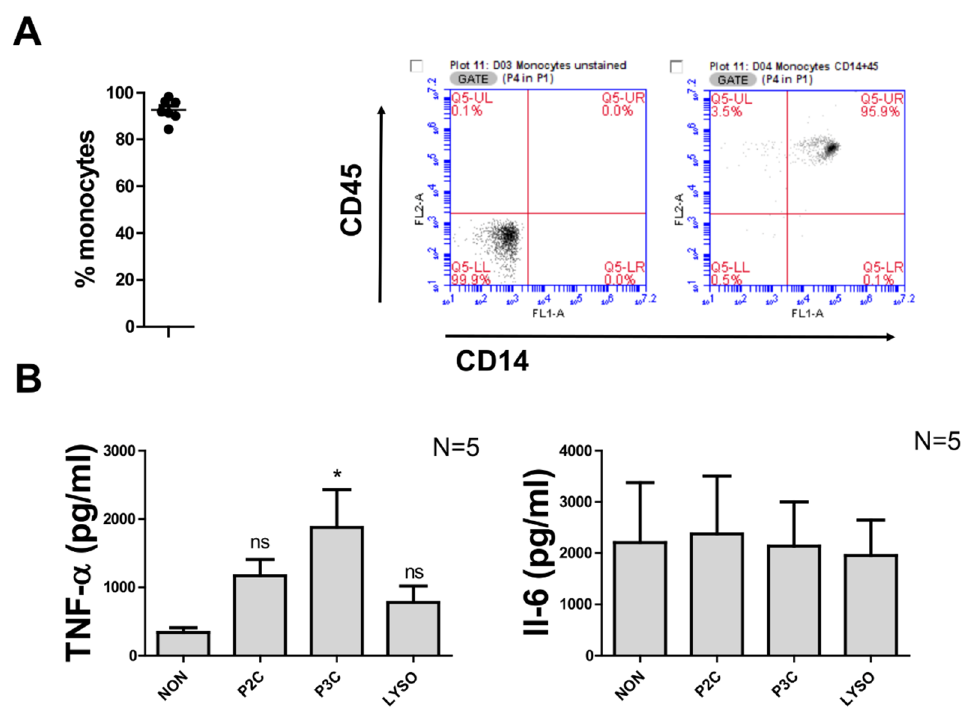
Figure 2. Monocyte production of CD14 + monocytes; positive isolation without resting. ( A ). Percentage of CD14 + monocytes from purified monocytes by CD14 + magnetic bead. Cells were stained with CD14-FITC and CD45-PE antibodies. Data were obtained from 7 donors. Flow cytometric analysis from a representative experiment with CD14 + monocytes unstained (left) and stained (right) with CD14-FITC and CD45-PE antibodies. ( B ) The 10 5 monocytes were stimulated with 100 ng/mL of P2C, P3C, or Lyso. The control samples (non) were used without adding any stimulators. TNF values were measured by ELISA from supernatant of 5 h stimulation, and IL6 and IL-10 were measured by ELISA from supernatant of 18 h stimulation. Samples from 4 donors were analysed in triplicate. Error bars represent SEM. Statistical significances were calculated between the treated cells compared to control (non) by using Kruskal–Wallis test: * p < 0.05; ns , not significant.